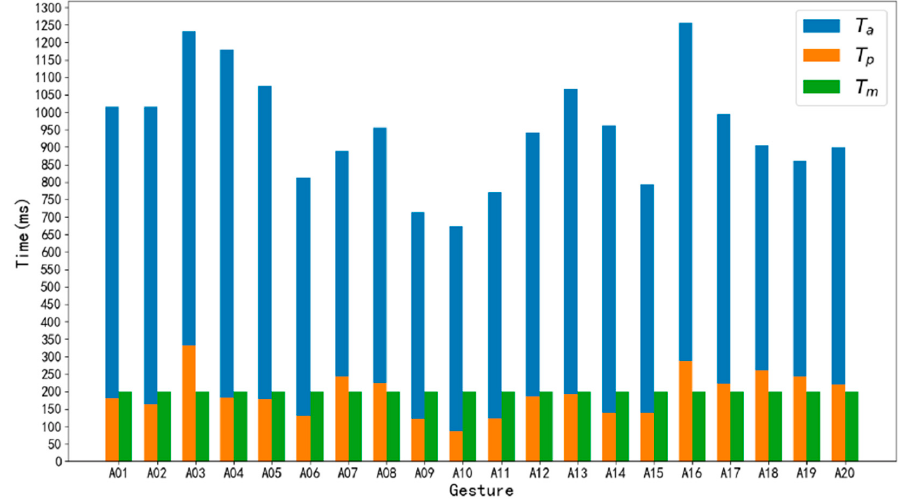
Figure 10. The comparison between T a , T p and T m of a